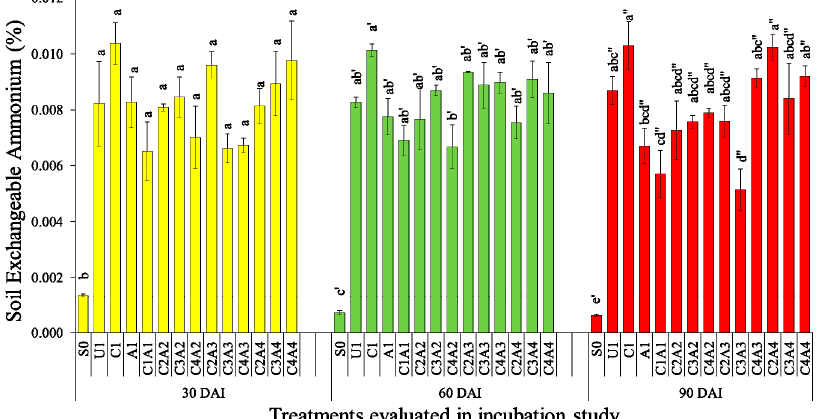
Figure 13. Treatments on soil exchangeable ammonium ions after thirty, sixty, and ninety days of incubation. Means with different letter(s) within the same incubation period indicate significant difference between treatments by Tukey’s HSD test at p ≤ 0.05. Bars represent the mean values ± SE.